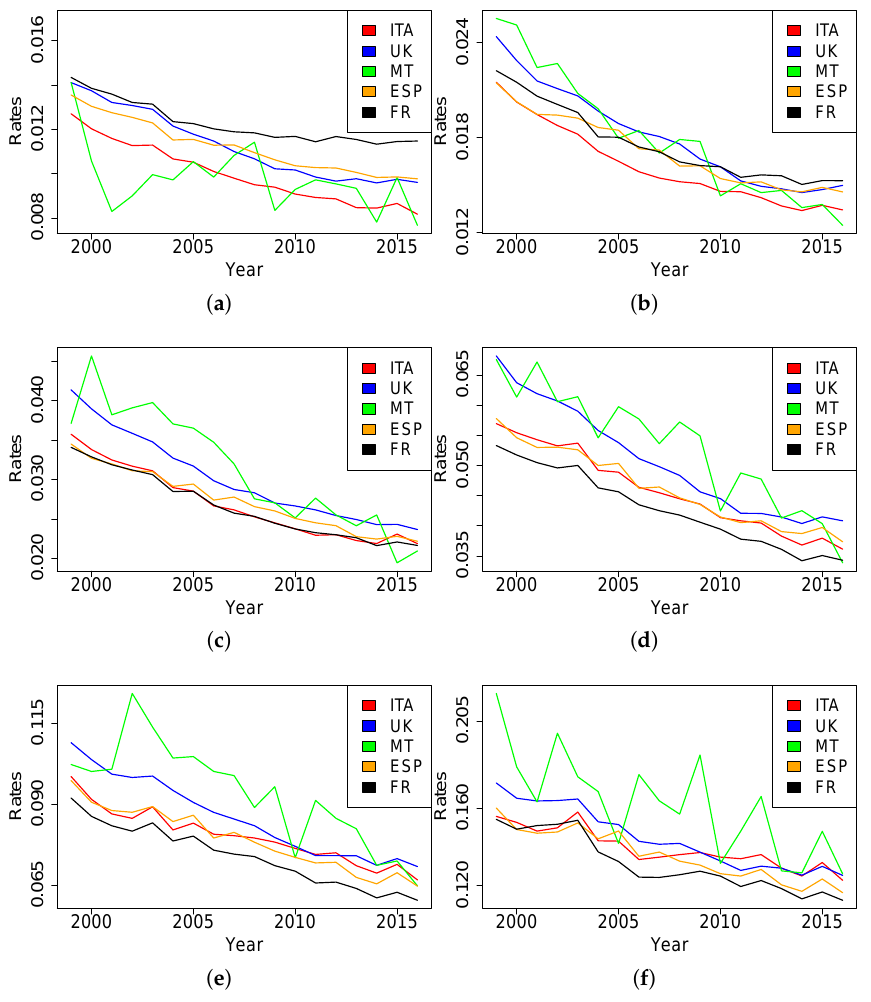
Figure 2. Age(-range)-specific male death rates: ( a ) at age 60–64, ( b ) at age 65–69, ( c ) at age 70–74, ( d ) at age 75–79, ( e ) at age 80–84, ( f ) at age 85–89.